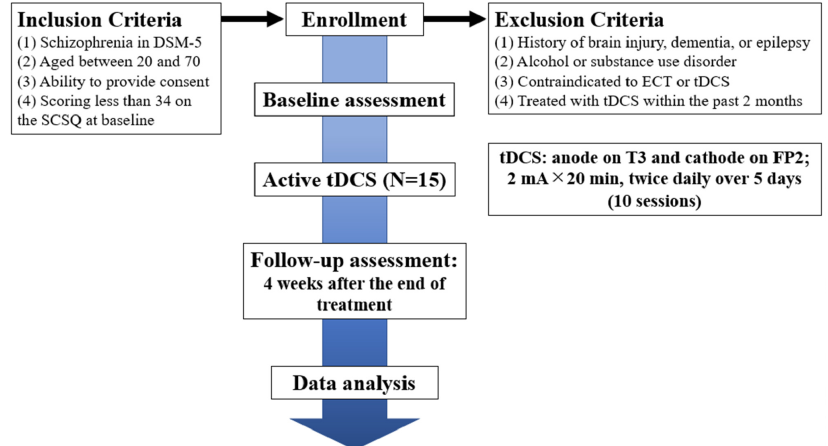
Figure 1. Flowchart summarizing the trial procedure. SCSQ, Social Cognition Screening Questionnaire; ECT, electroconvul- sive therapy; tDCS, transcranial direct current